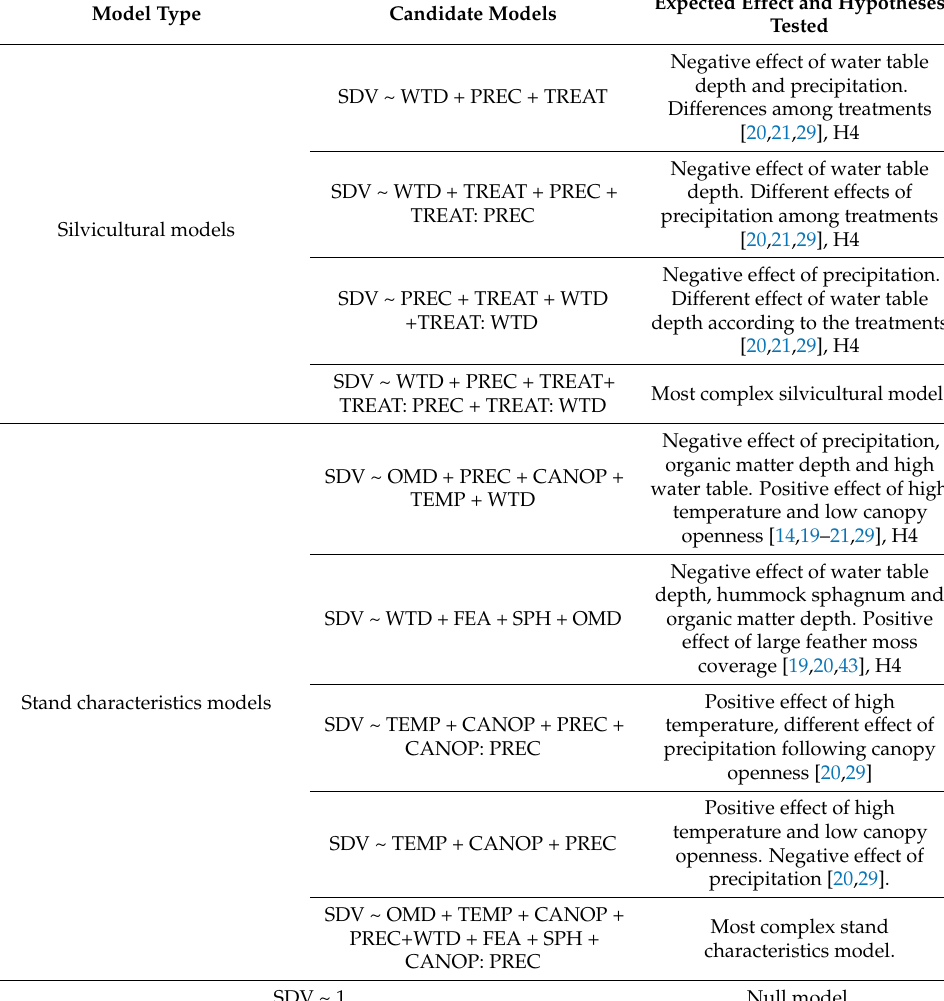
Table 4. List of candidate models explaining daily stem diameter variation ( SDV ) of black spruce during the 2017 growing season. Variable selection was based upon effects of silvicultural treatments and stand characteristics: silvicultural treatments (TREAT) with three different levels (control, par- tial harvest, girdling); precipitation (PREC); standardized water table depths (WTD); temperature (TEMP); canopy openness (CANOP); organic matter depths (OMD); and feather moss and sphagnum (FEA, SPH). The third column includes the expected effect, the hypotheses tested and the associated